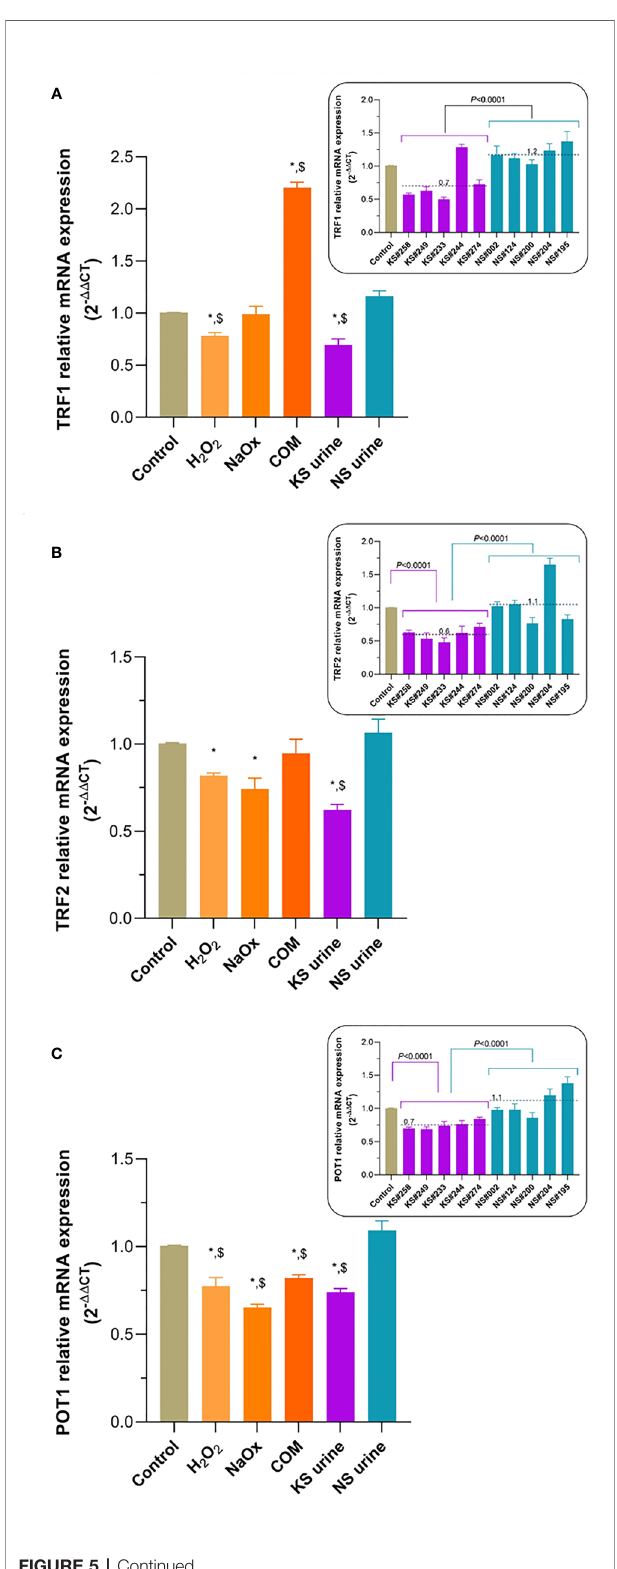
FIGURE 5 | Transcript expression of TRF1, TRF2, and POT1 in HK-2 cells exposed to lithogenic factors. (A) TRF1 mRNA expression was signi fi cantly lower in cells after treatment with H 2 O 2 or urine from patients with KS (KS urine), but signi fi cantly higher after treatment with calcium oxalate monohydrate (COM), compared with that in untreated controls or after treatment with urine from donors without KS (NS urine). (B) Treatment of HK- 2 cells with H 2 O 2 or NaOx signi fi cantly decreased TRF2 mRNA expression compared with that in untreated control cells, but KS urine treatment signi fi cantly decreased TRF2 mRNA expression compared with that in both untreated control cells and those treated with NS urine. (C) POT1 mRNA expression was signi fi cantly decreased in HK-2 cells treated with H 2 O 2 , NaOx, COM, and KS urine compared with that in untreated control cells or those treated with NS urine. Insets show expression of TRF1, TRF2, and POT1 mRNA after treatment with individual samples of urine from patients with KS (KS samples) compared with treatment with inidividual samples from donors without KS (NS samples). Dashed line and number indicate mean. Error bars indicate SEM of at least triplicate treatments. * P < 0.05 vs. Control, $ P < 0.05 vs.